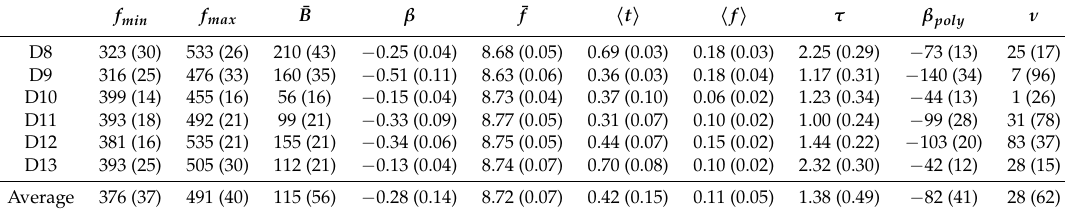
Table A2. Humpback D-moan sub-classification result for the FB-GSC direction. The quantity in parenthesis indicates the standard deviation. The D-moans from 1–3 October are analyzed